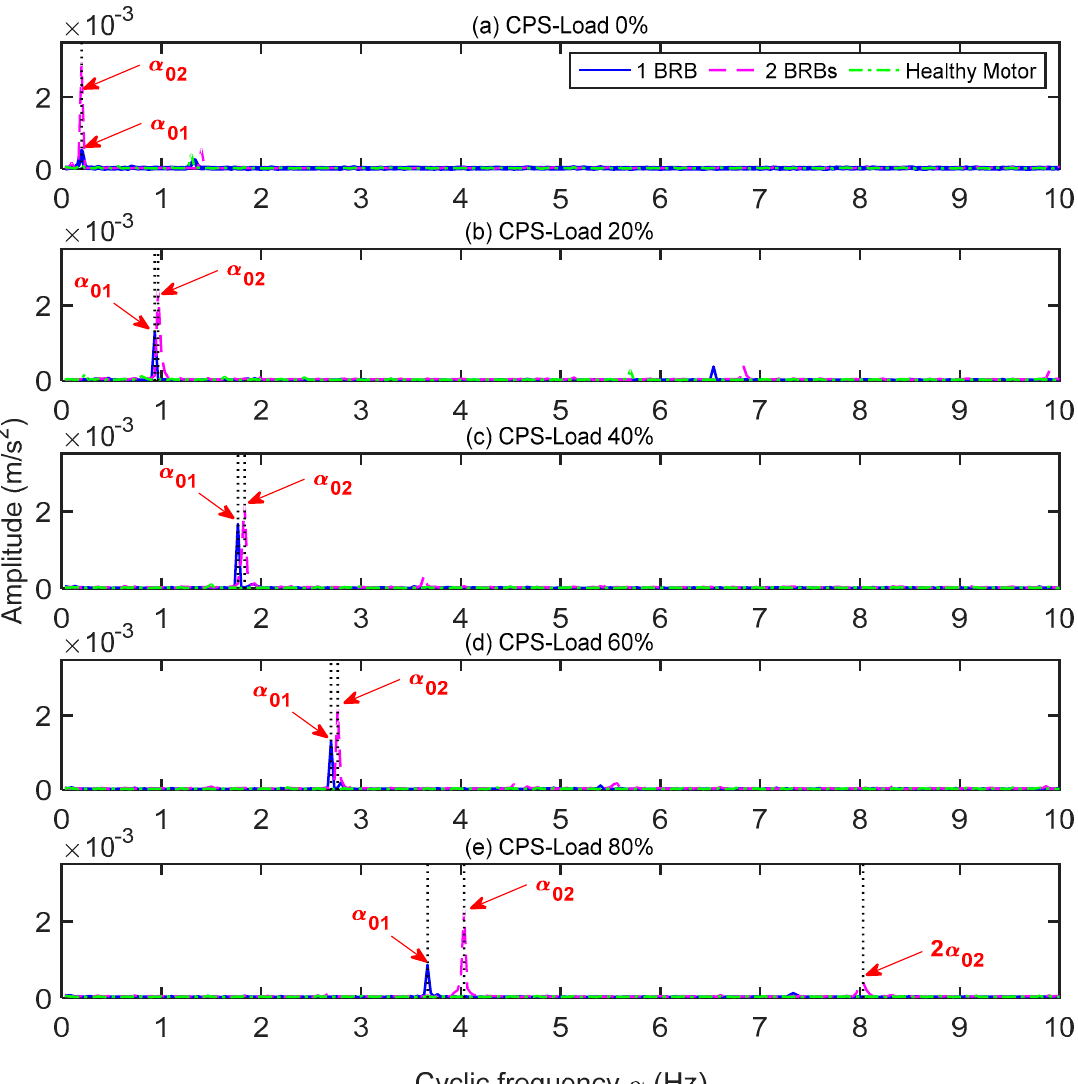
Figure 8. The characteristic frequencies of α 01 and α 02 for 1 BRB and 2 BRBs based on the cyclic power spectrum (CPS) method at ( a ) 0% load, ( b ) 20% load, ( c ) 40% load, ( d ) 60% load, and ( e ) 80% load under operating condition. Blue for 1 BRB, Pink for 2 BRBs, and Green under healthy motor.